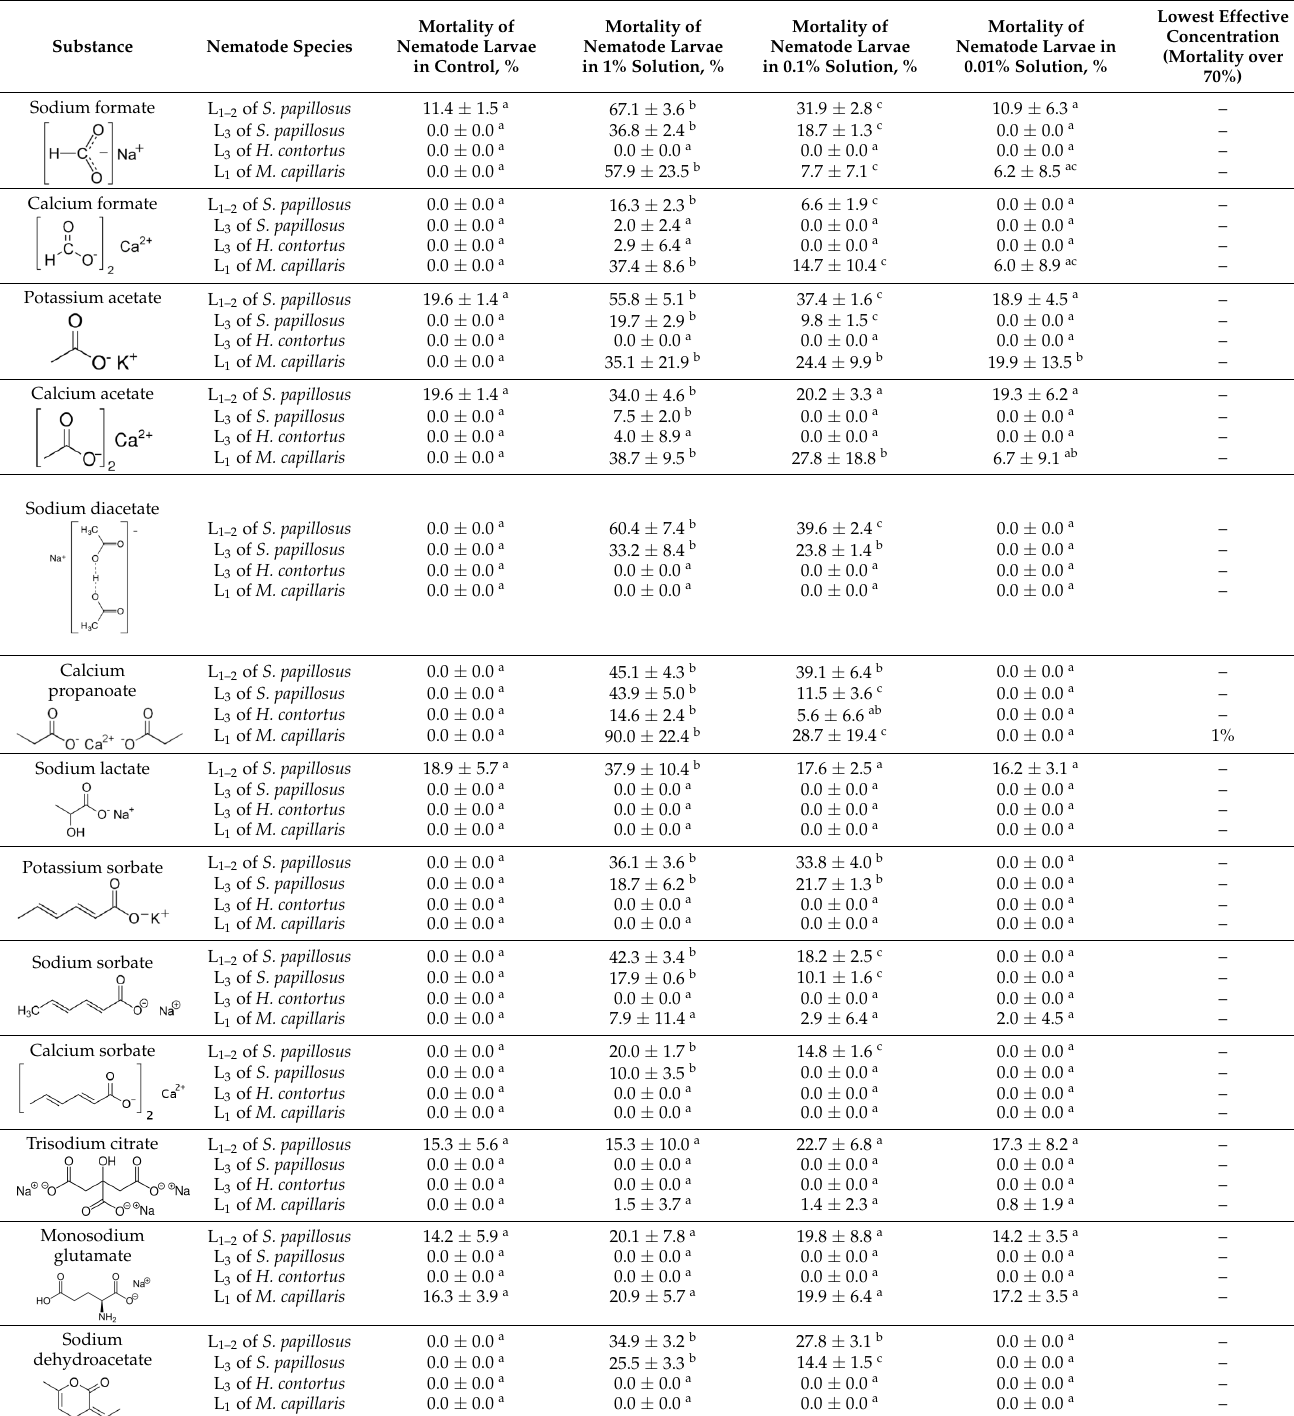
Table 4. Mortality of larvae of S. papillosus , H. contortus , and M. capillaris (%) during 24 h laboratory experiment under the influence of salts of organic acids, used as food additives (x ± SD, n = 5). Mortality of Nematode Substance Species